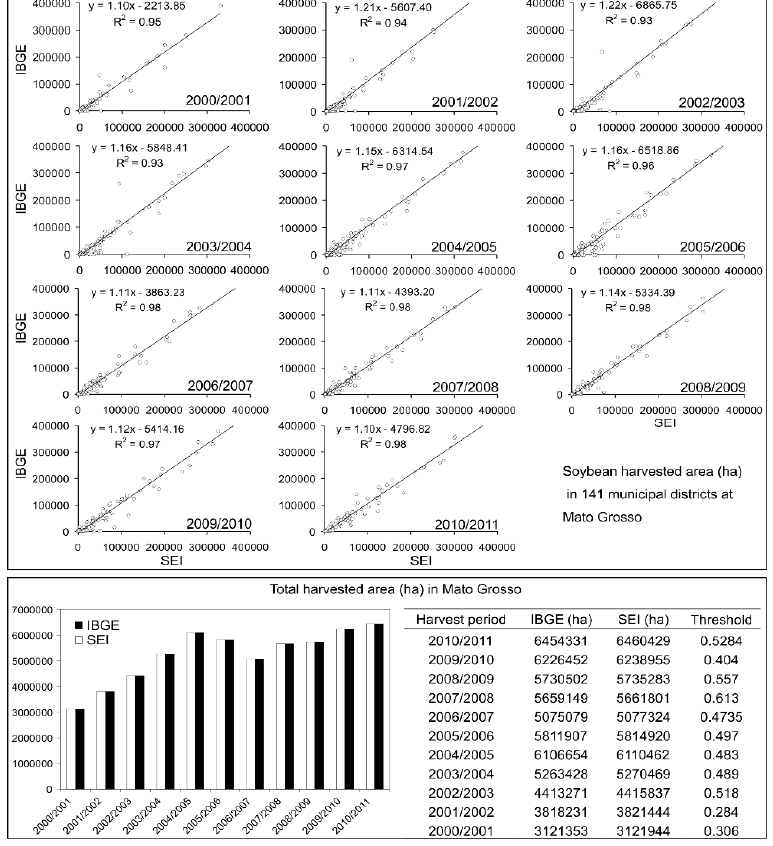
Figure 5. Evaluation of the model for soybean harvested area estimation based on Moderate Resolution Imaging Spectroradiometer (MODIS) data, when compared to IBGE statistics per municipality and the total harvested area in Mato Grosso.